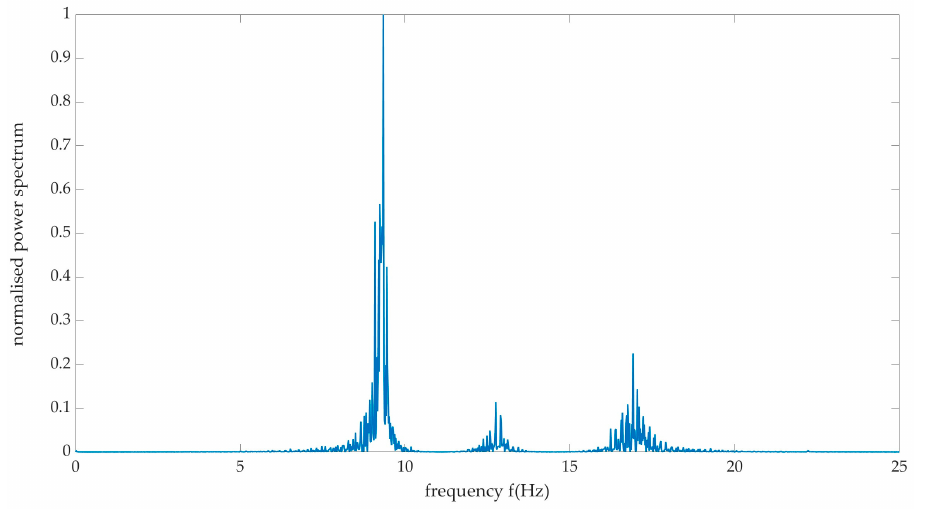
Figure 2. FFT normalized power spectra from y-axes accelerometer output.